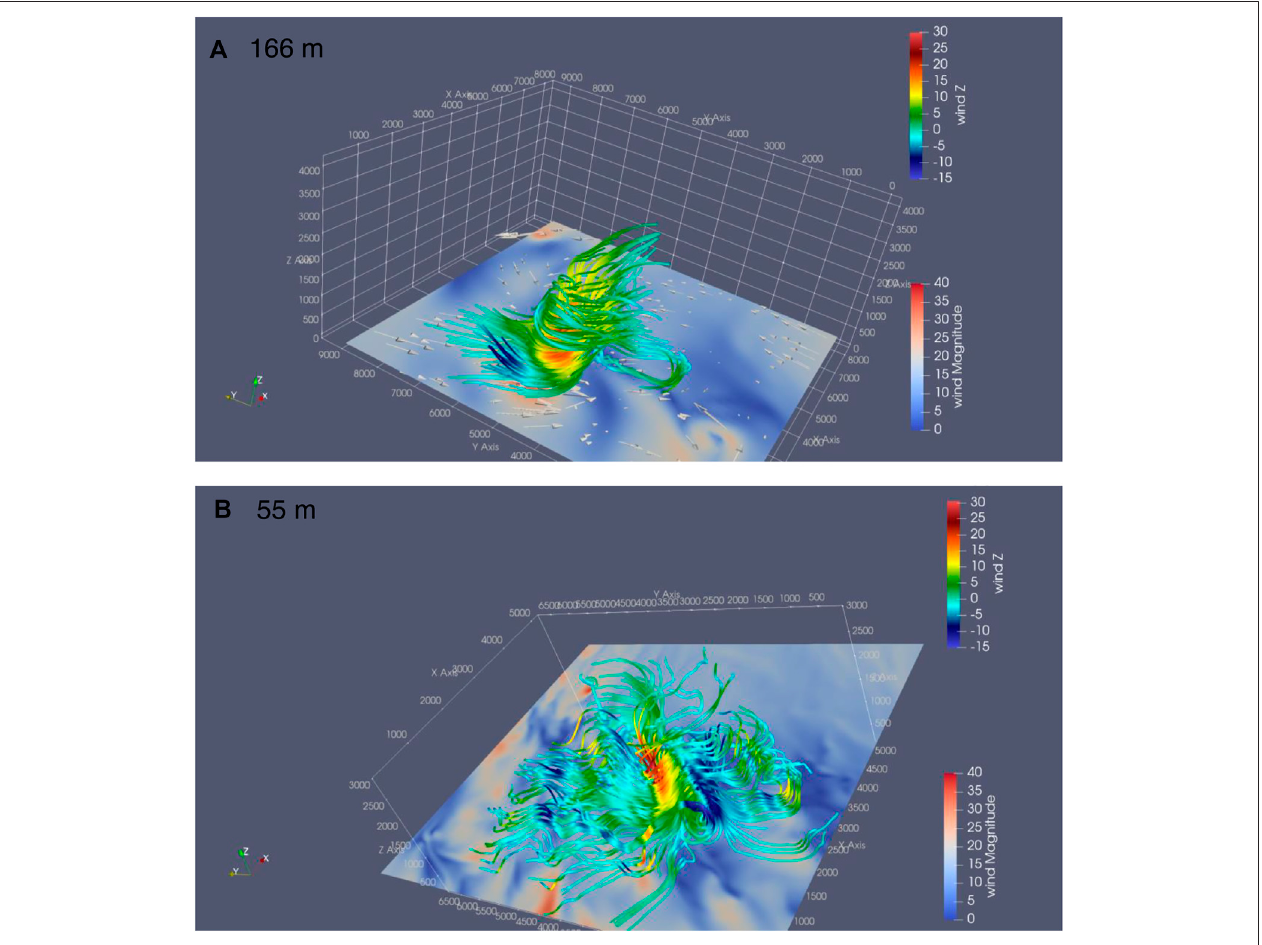
FIGURE12| Three-dimensionalstreamlinesofperturbationwind(m s − 1 )coloredwithverticalvelocity(m s − 1 )andsurfaceperturbationwindspeed(shaded,m s − 1 ) at t (cid:2) 9 h of the simulation from the grid spacings of (A) 166 m and (B) 55 m. The scale of vertical coordinate is doubled as its size is much smaller than the horizontal coordinate.